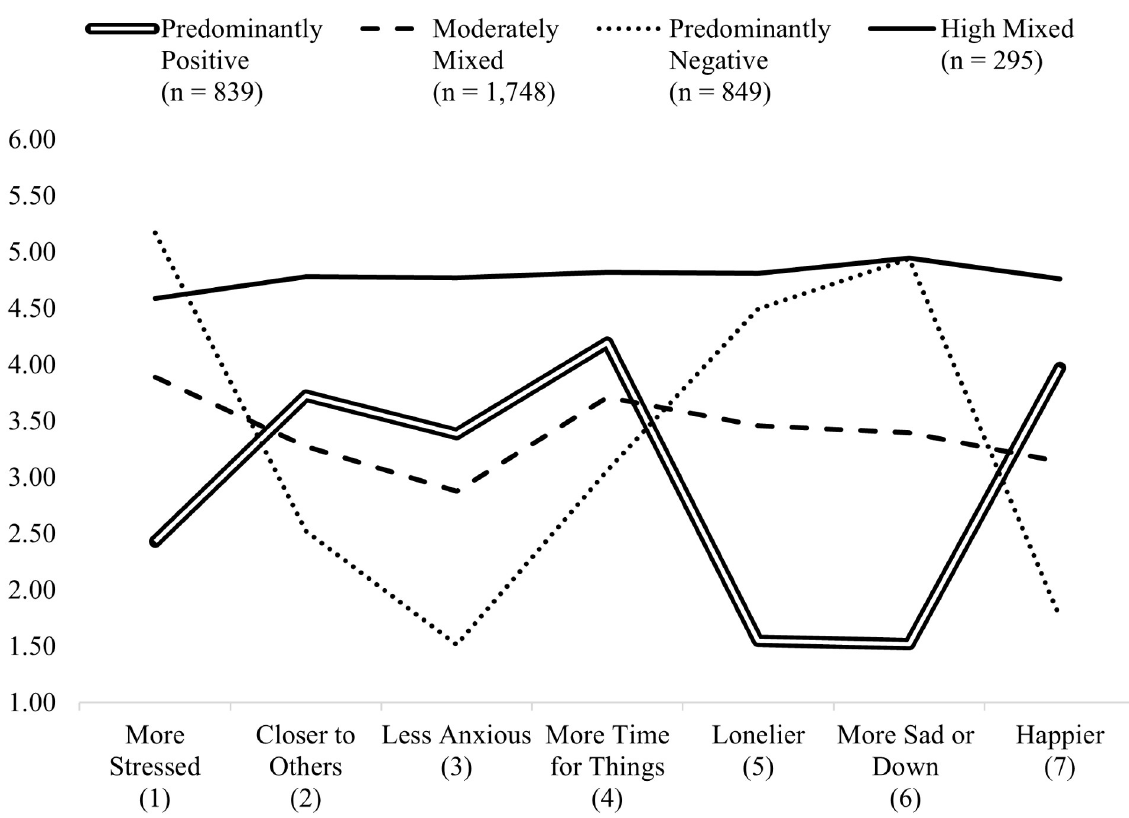
Fig 2. Means for the seven items across each of the four